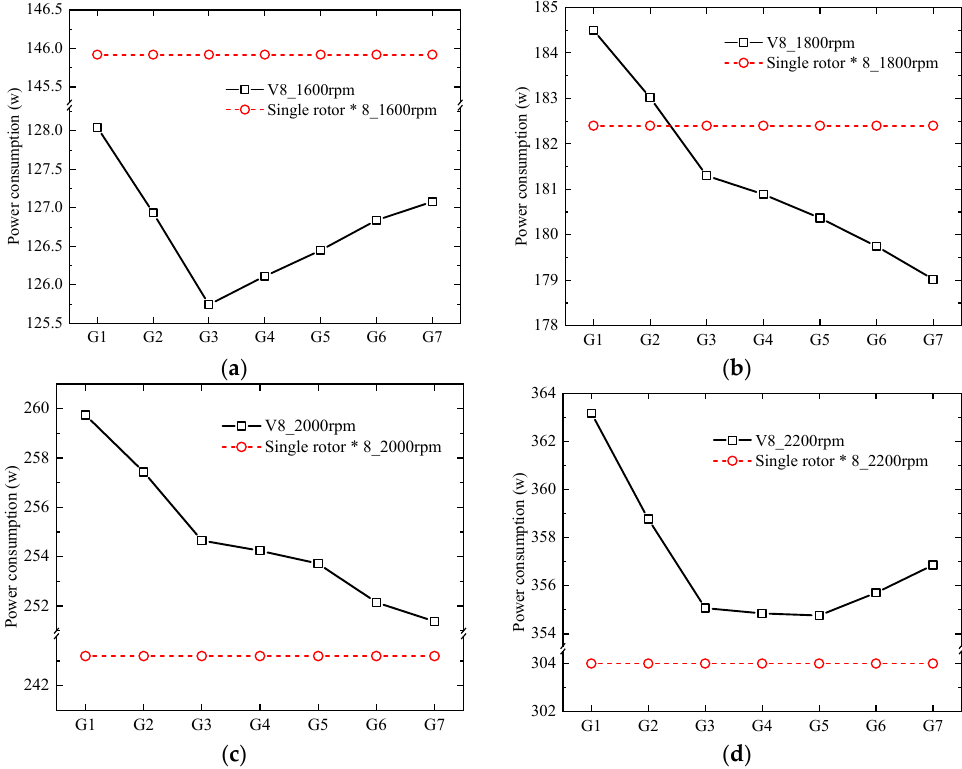
Figure 7. Power variation. ( a ) 1600 rpm; ( b ) 1800 rpm; ( c ) 2000 rpm; ( d ) 2200